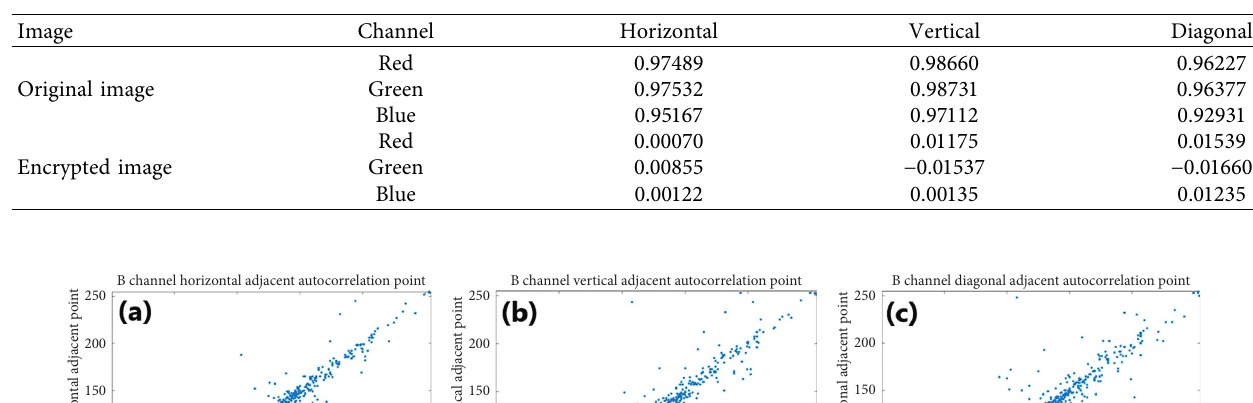
Table 4: Correlation coefficient test result [36].